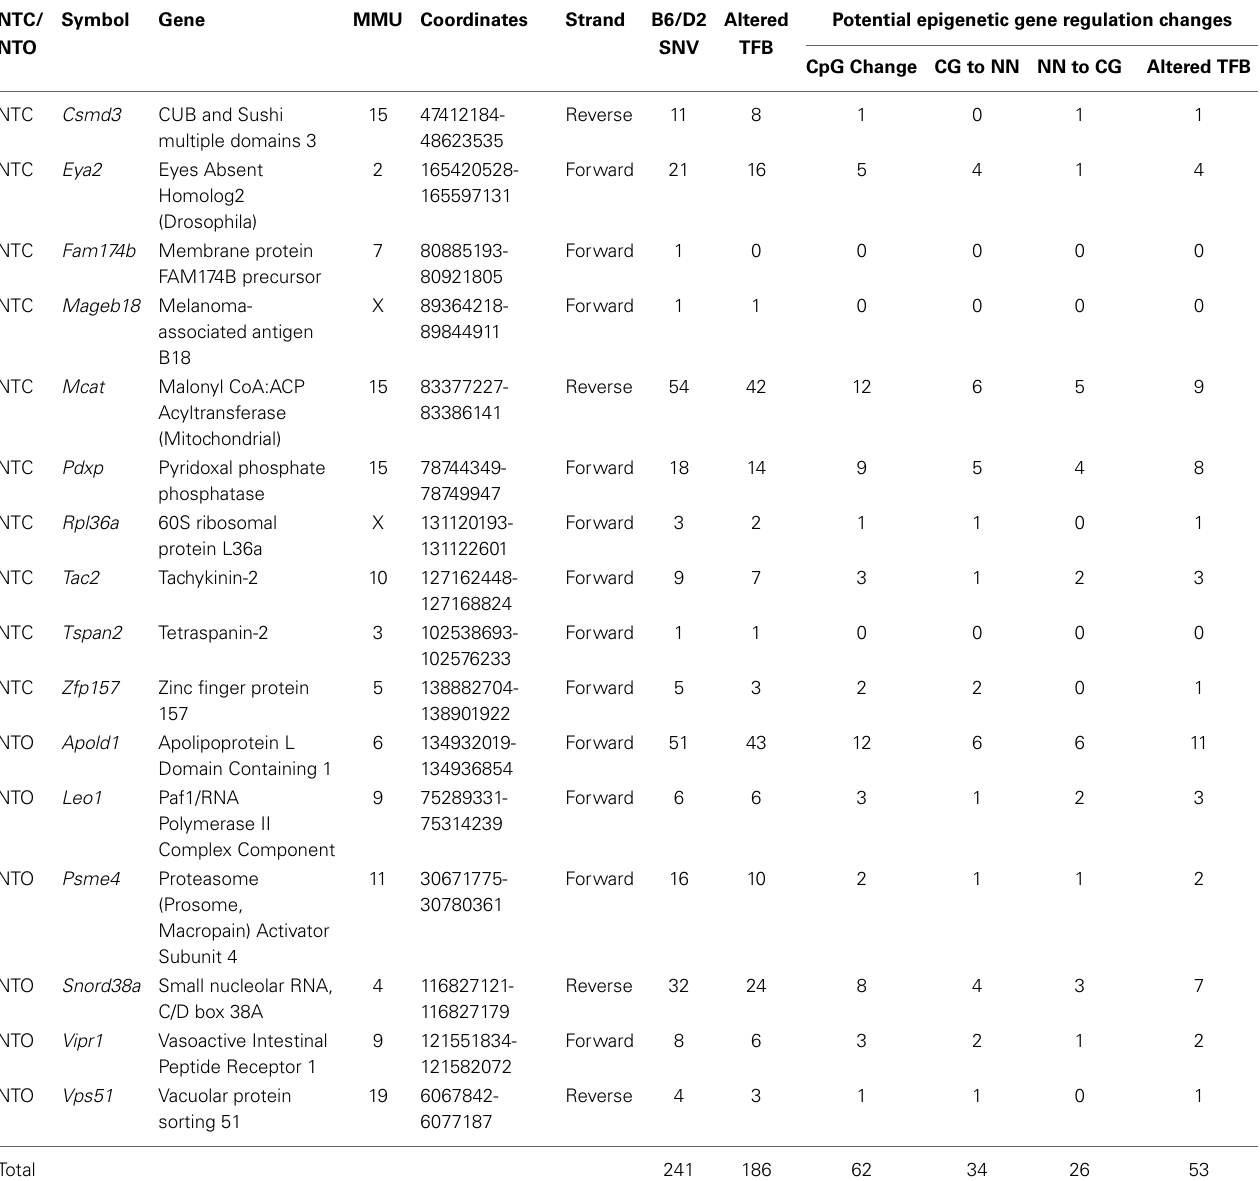
Table 4 | Summary of the potential regulatory effects of the SNVs between C57BL/6NJ and DBA/2J in genes demonstrating GxE interactions. NTC/